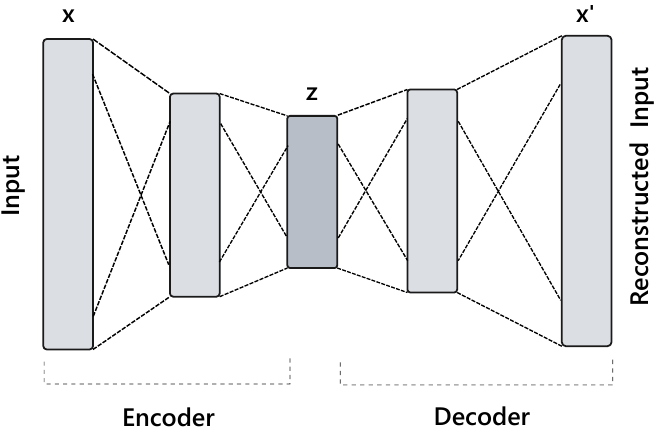
Figure 2. Illustration of an autoencoder network. Figure 5. Illustration of an autoencoder network